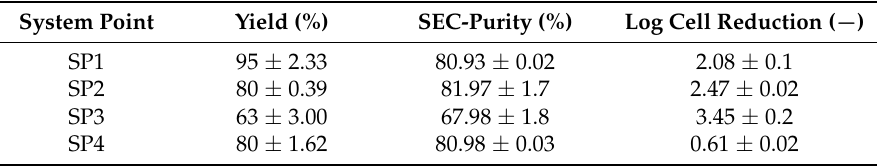
Table 1. Yield, purity, and cell reduction of the investigated ATPS.